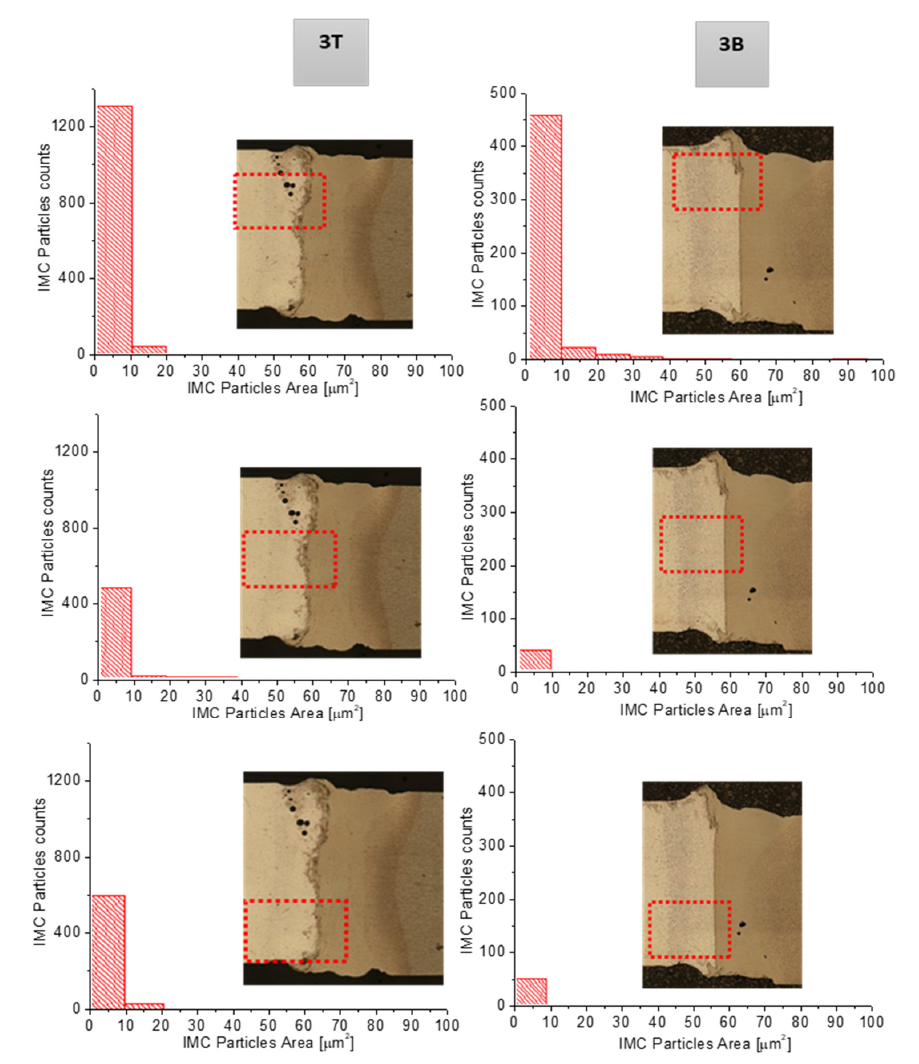
Figure 10. IMC particles distribution along the thickness of joints 3T and 3B.